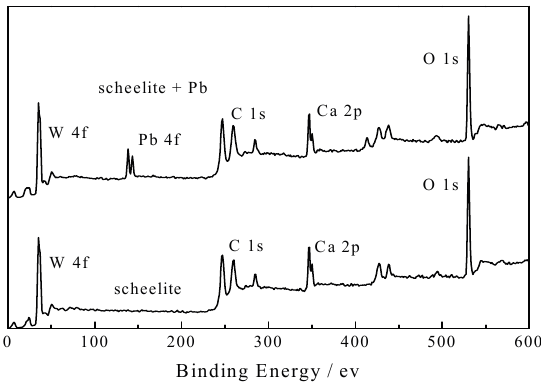
Figure 4. Spectra of atom orbitals for scheelite before and after lead adsorbed.